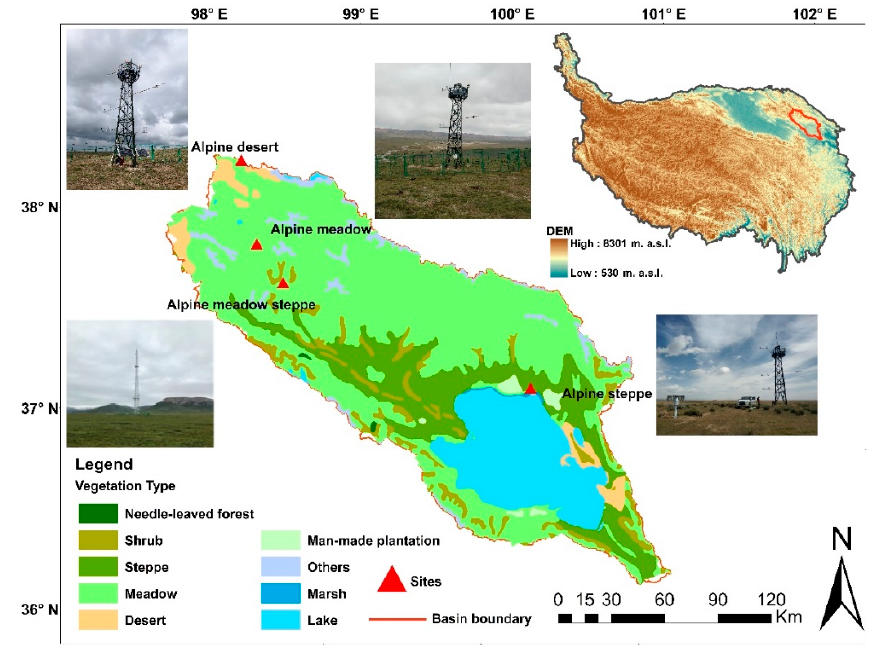
Figure 1. Location of Qinghai Lake Basin and observation sites.